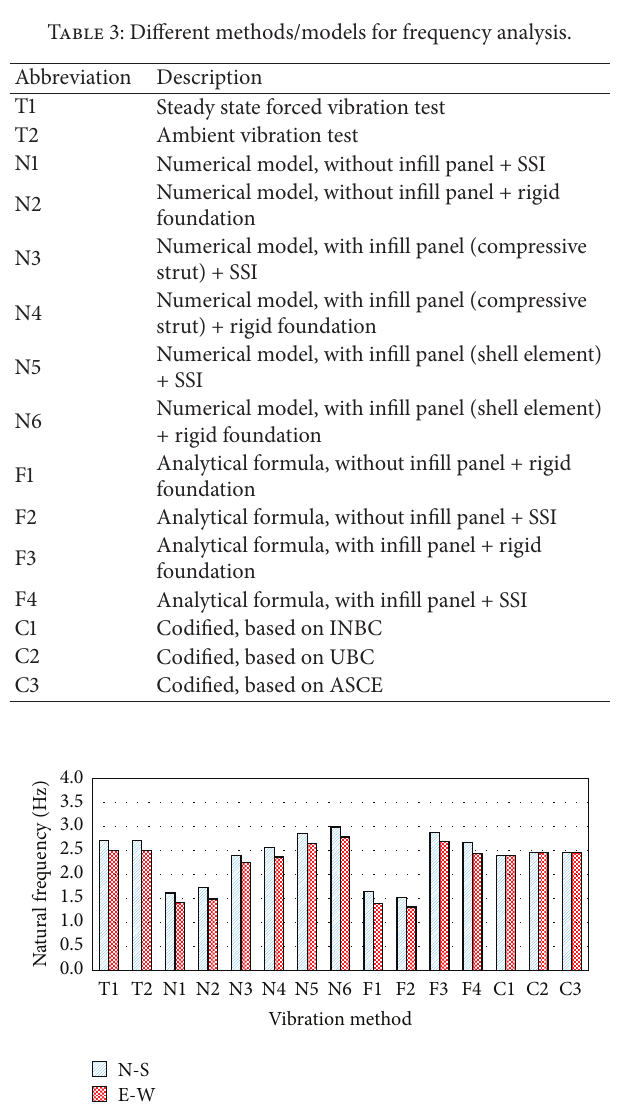
Figure 10: Natural frequencies of the building in two orthogonal